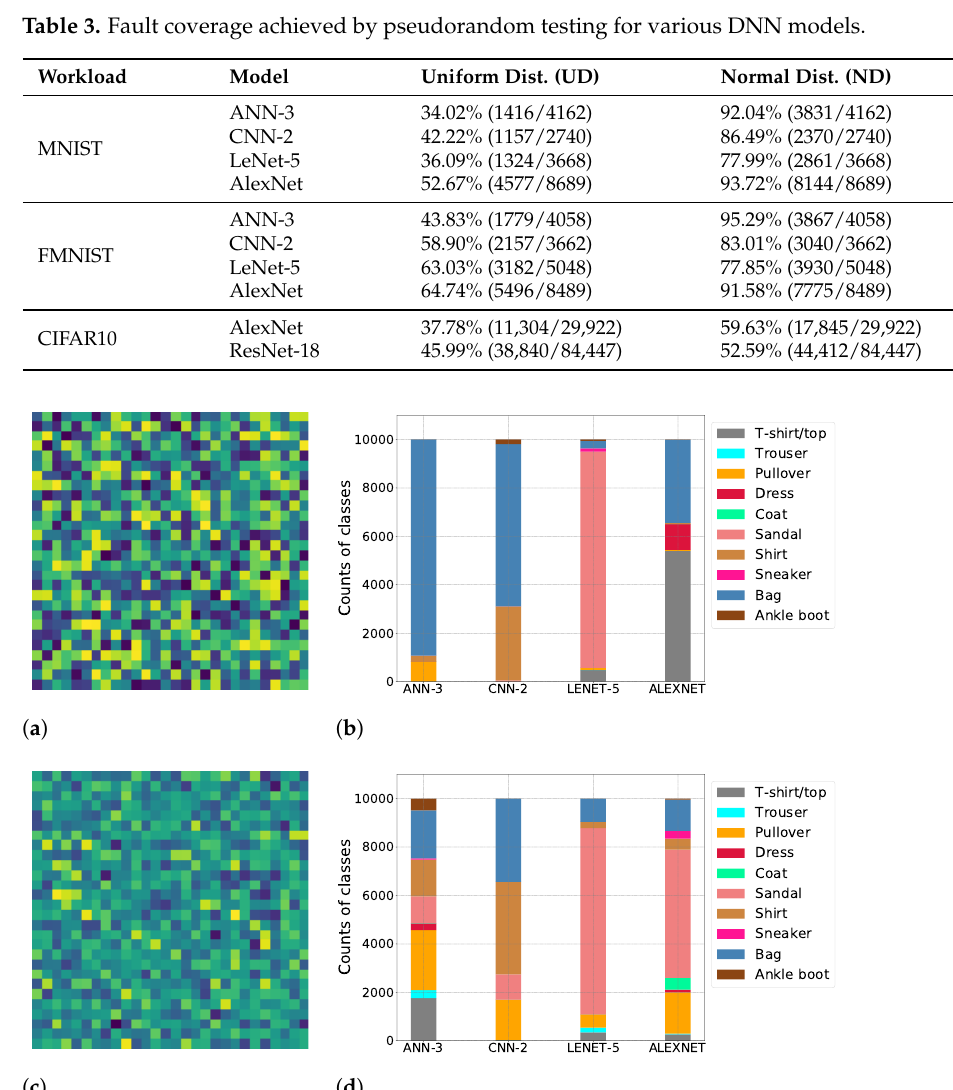
Figure 4. Images in ( a , c ) visualize tests generated using uniform and normal distributions, respec- tively. Here, pixels are colored using a heat map in which smaller values appear darker. Graphs in ( b , d ) count the output labels predicted by the DNNs when supplied with test patterns from T UD and T ND , respectively. ( a ) A sample test from T UD . ( b ) Labels predicted by DNNs trained on FMNIST for tests ∈ T UD . ( c ) A sample test from T ND . ( d ) Labels predicted by DNNs trained on FMNIST for tests ∈ T ND